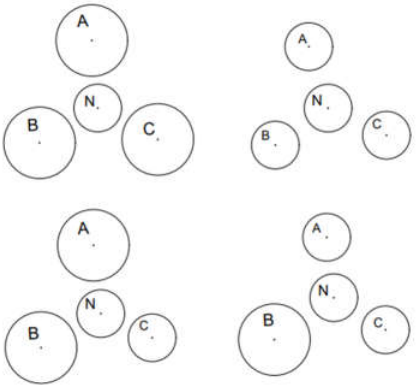
Figure 2. Nodes A, B and C are far from each other. large coverage hole. A mobile node is set at the center of the common circumscribed circle of the three nodes to cover nodes A, B and C, thereby making up the hole.